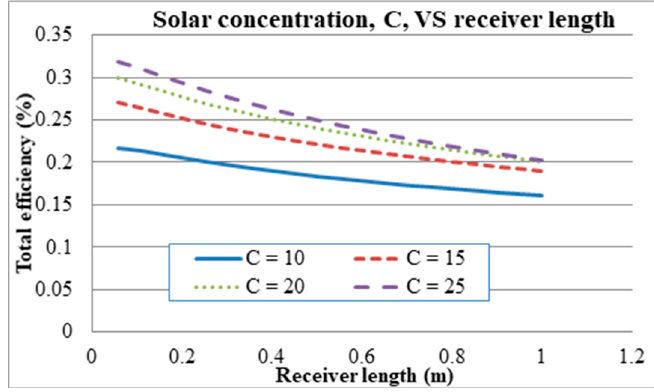
Figure 16. Solar concentration at different receiver lengths.